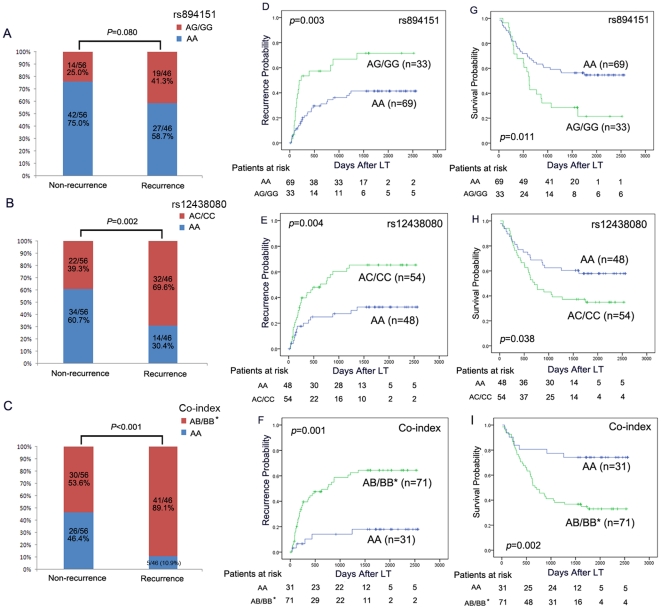
Prognostic significance assessed using Kaplan–Meier survival estimates and log-rank tests stratified by rs894151 (D, G), rs12438080 (E, H), and the co-index of the two factors (F, I).
A, B, and C show the frequency distributions of genotypes in the non-recurrence and recurrence groups with the p-value calculated by chi-square test. *B represents a minor allele. Patients were divided into two groups by the co-index: patients with AA at both rs894151/rs12438080 and patients with minor allele(s).